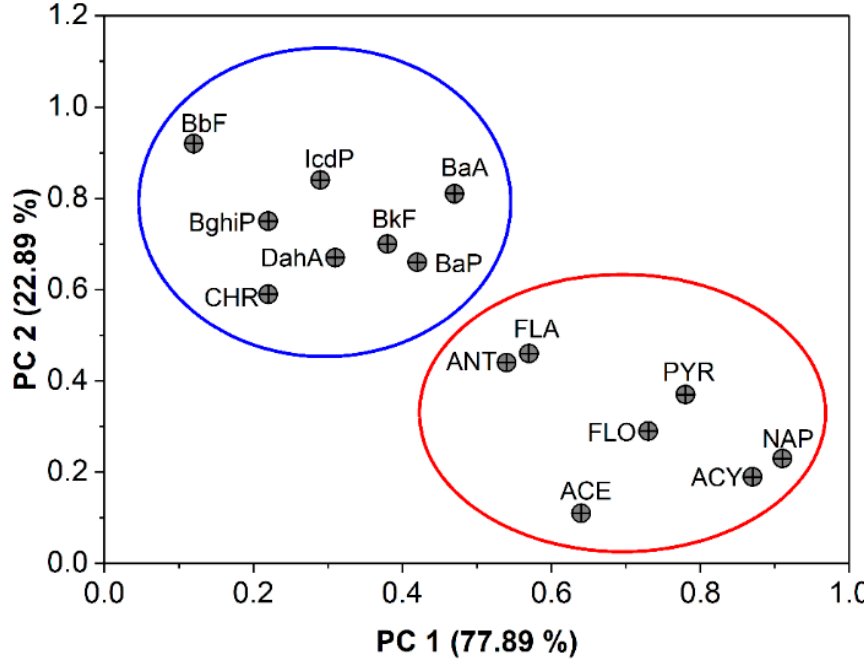
Figure 6. Principal component analysis (PCA) loading plot for 15 individual PAHs in soil.